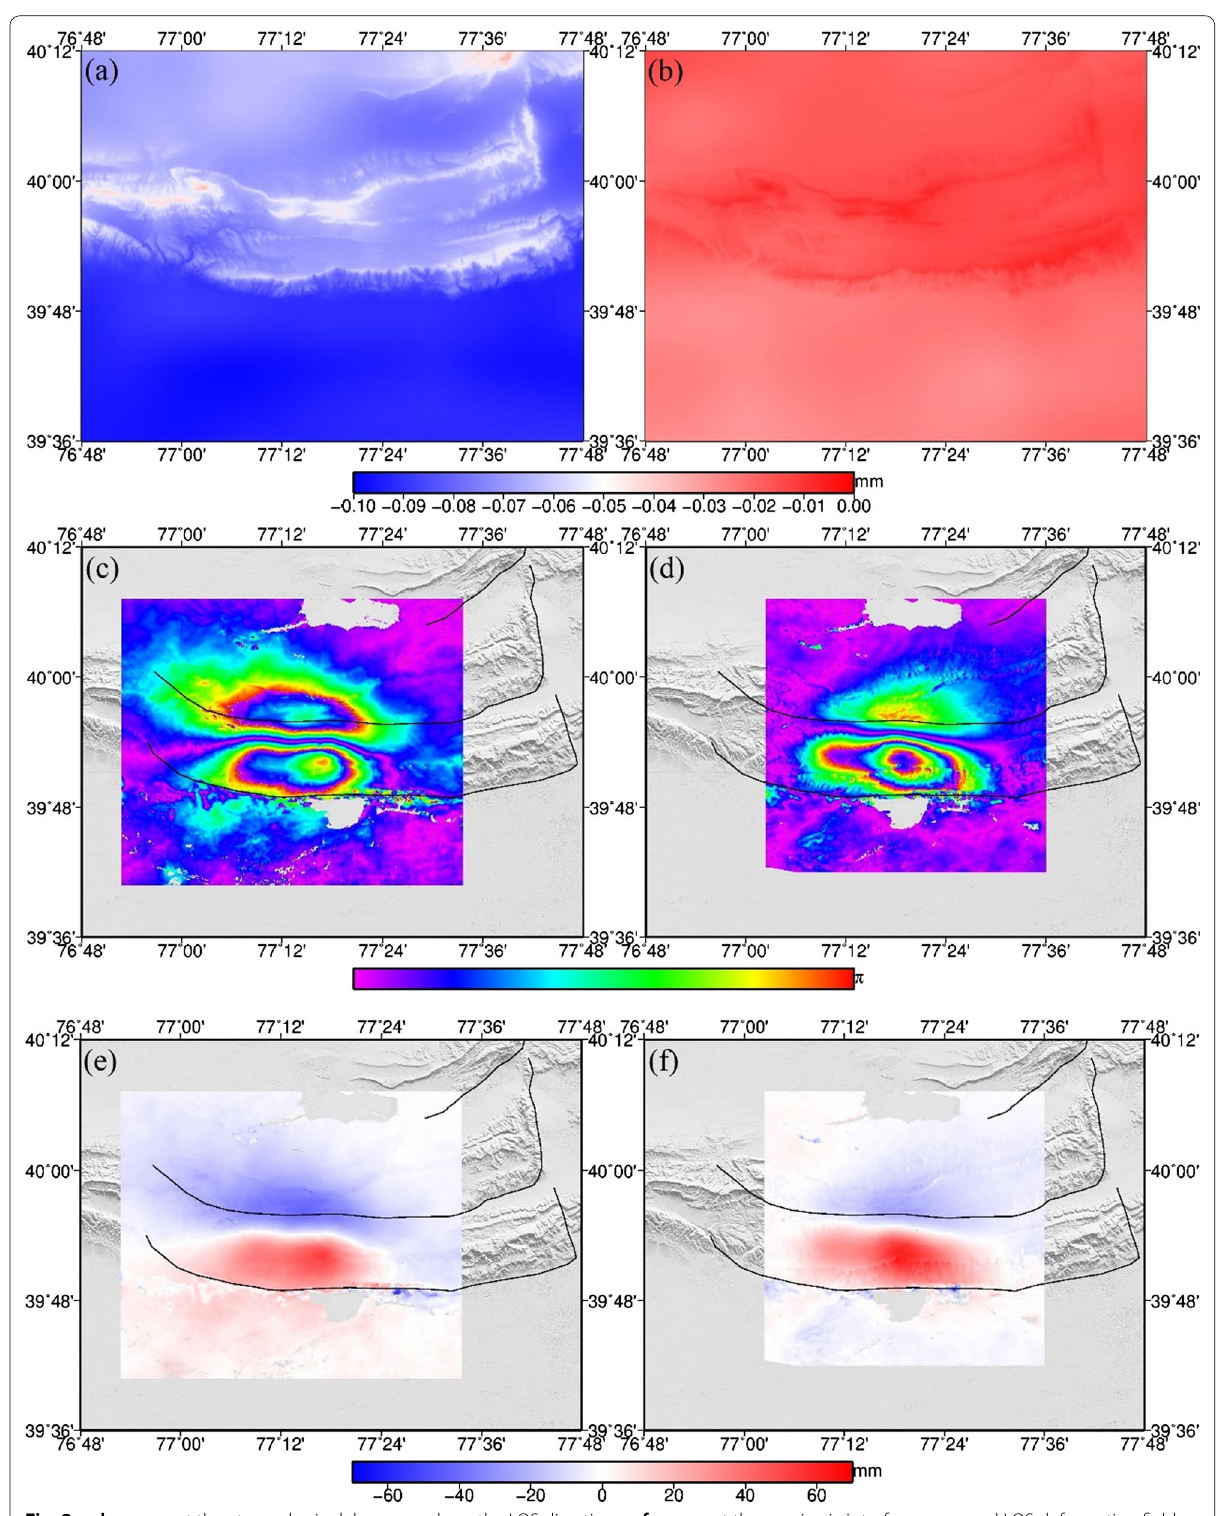
Fig. 2 a , b represent the atmospheric delay maps along the LOS direction. c – f represent the coseismic interferograms and LOS deformation fields with atmospheric delay corrected along ascending and descending orbits,